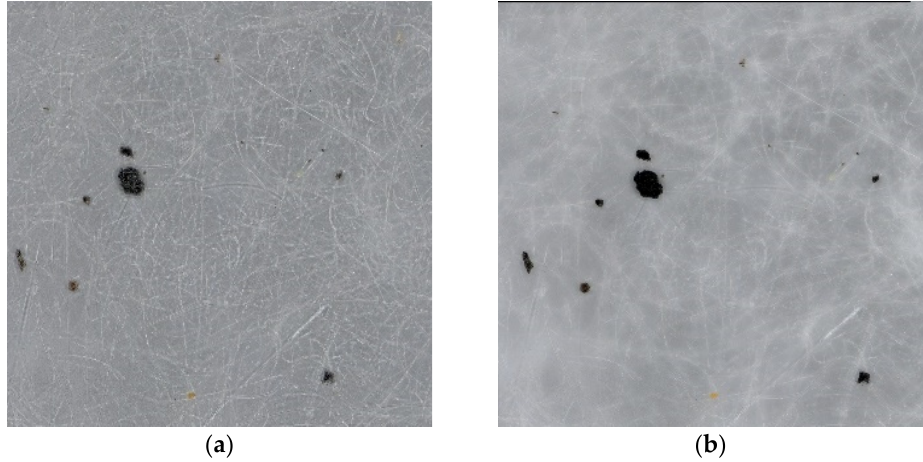
Figure 2. ( a ) Microscope image of a filter area of the RDE cycle, original; ( b ) edited image with